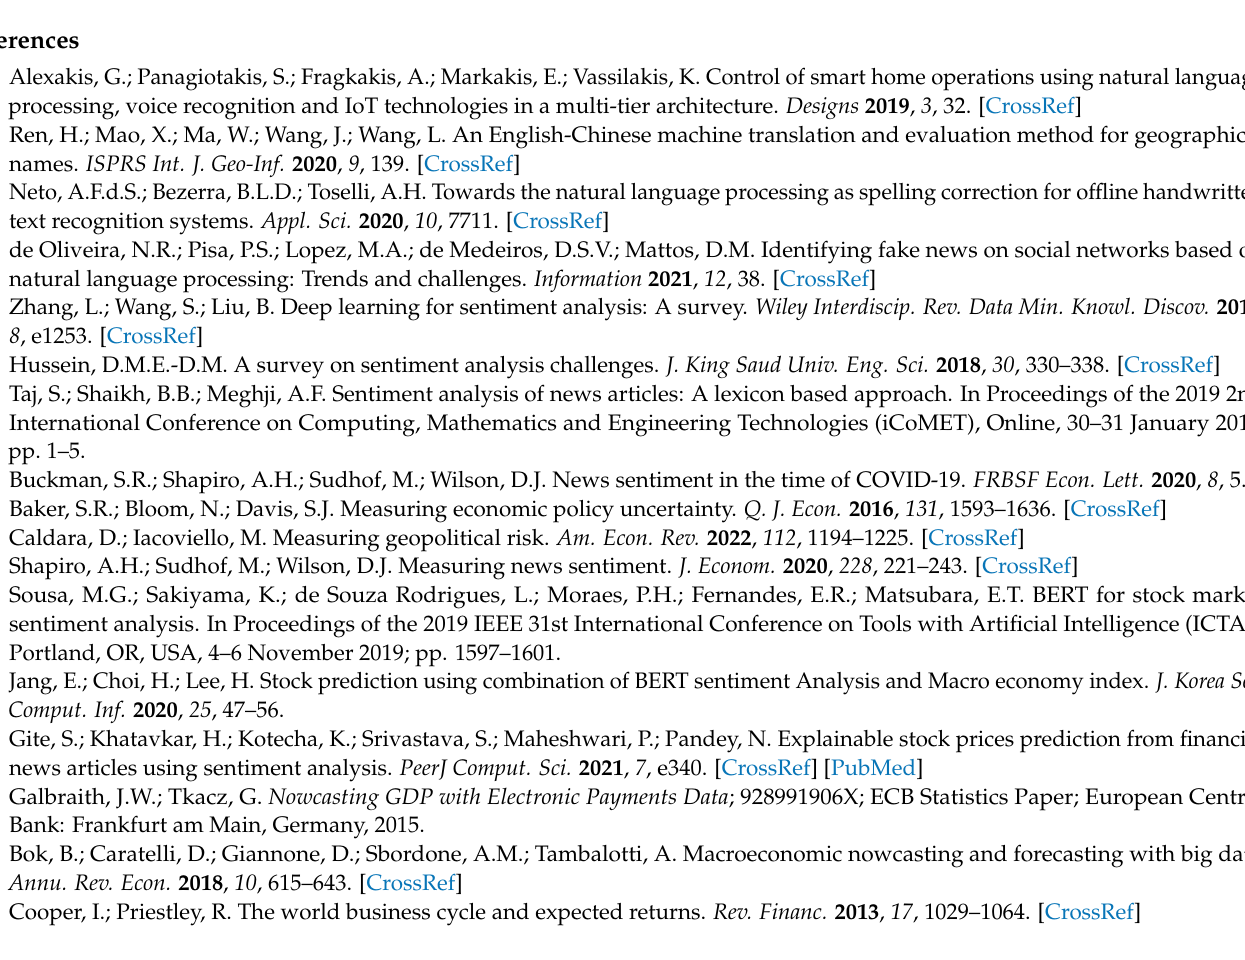
Figure A6. Sentiment analysis of news titles and leads over time for category “ Health ” news.